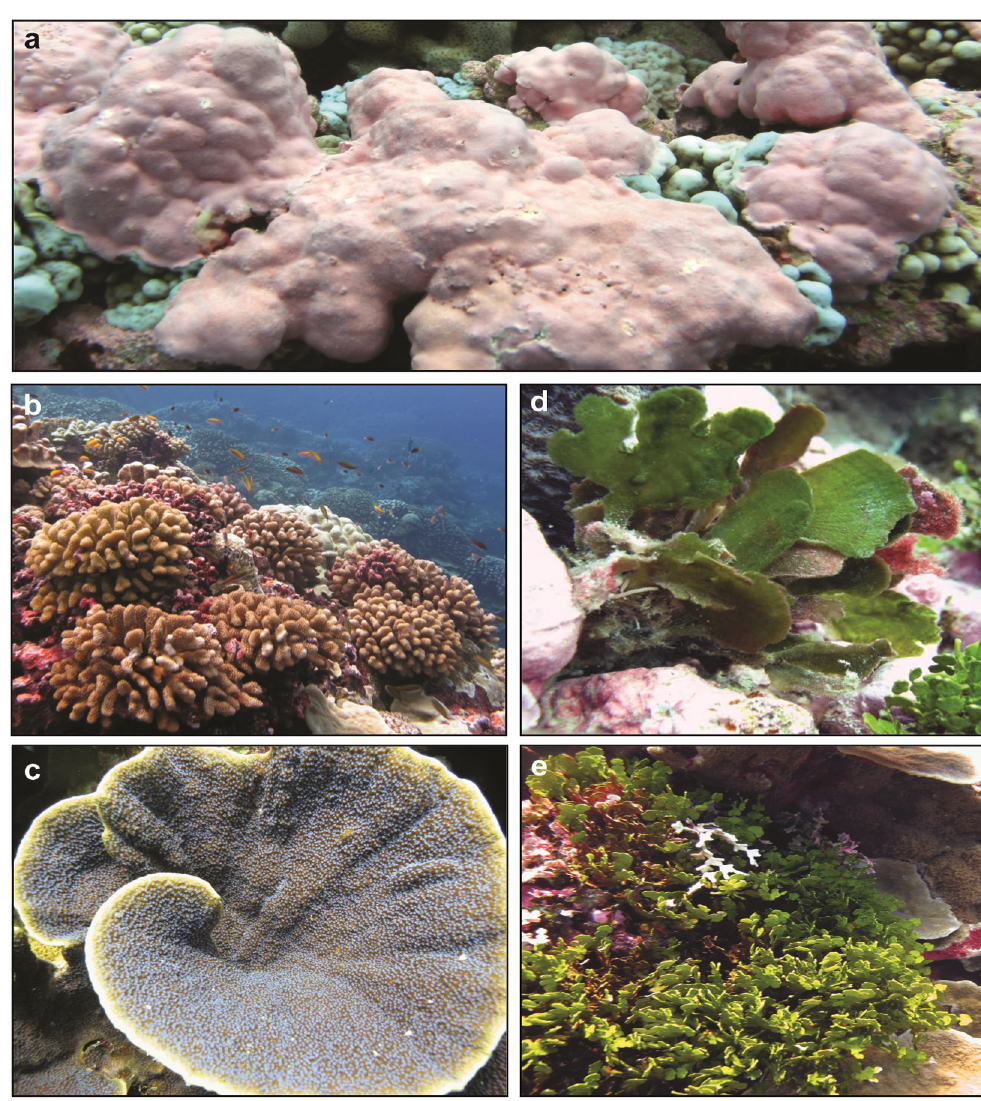
Fig 1. Coral and algae of the Southern Line Islands. Common genera of corals and algae across the Southern Line Islands in the Republic of Kiribati, central Pacific. (a) The crustose coralline alga, Porolithon sp. and (b) the corals Pocillopora meandrina and (c) Montipora aequituberculata were collected from all five islands. (d) The fleshy green alga Avrainvillea amadelpha was found only at Vostok and Malden, and (e) the calcareous green alga, Halimeda sp., was found at Flint, Millennium and